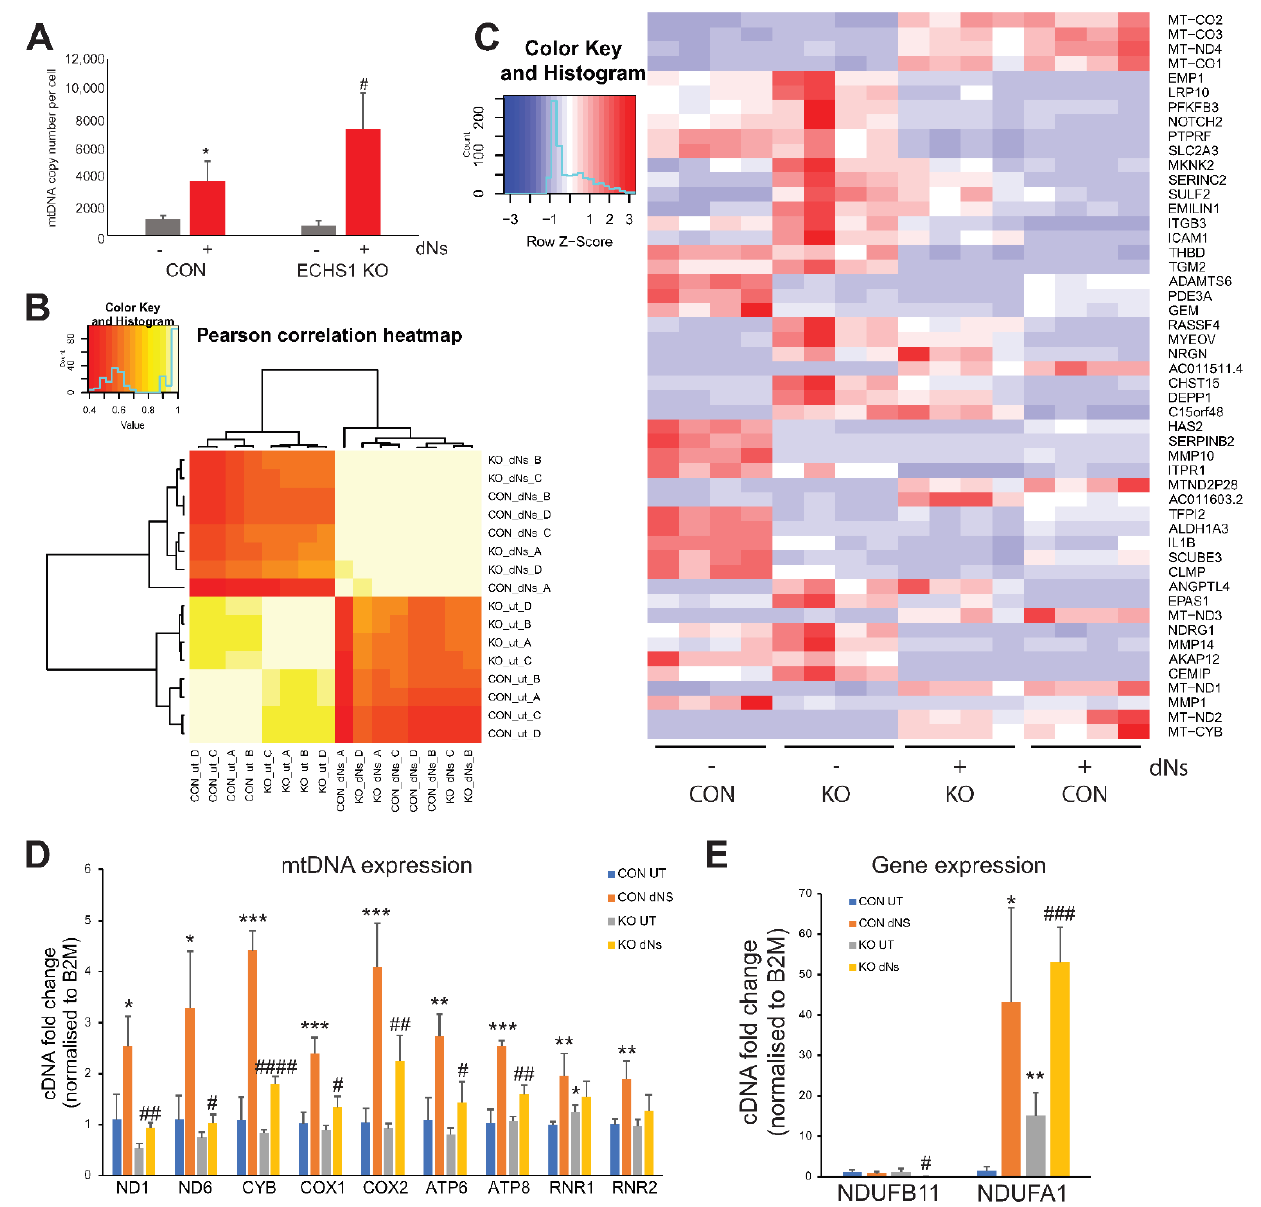
Figure 1. dNs treatment increased mtDNA copy number and alters global gene expression. ( A ) MtDNA copy number was increased in both control (CON) and ECHS1 KO cells after 8 days of dNs treatment. ( B ) Pearson correlation heatmap of transcriptome expression in CON cells and ECHS1 KO (KO) cells, either untreated (ut) or treated with dNs for 8 days. ( C ) Heatmap of 50 most significantly differentially expressed genes across all samples. The expression of mtDNA-encoded transcripts was increased in both CON and ECHS1 KO cells following dNs treatment. ( D ) Expression of mtDNA-encoded transcripts was increased following dNs treatment in both CON and ECHS1 KO cells. ( E ) Expression of nuclear-encoded OXPHOS complex I subunit genes were increased in both CON and ECHS1 KO cells following dNs treatment. Data shown is mean ± standard deviation (s.d.), with n ≥ 3. * p < 0.05, ** p < 0.01, *** p < 0.001 compared to untreated (ut) CON cells; # p < 0.05, ## p < 0.01, ### p < 0.001, #### p < 0.0001 compared to untreated (ut) ECHS1 KO cells (Student’s two-tailed t tests).